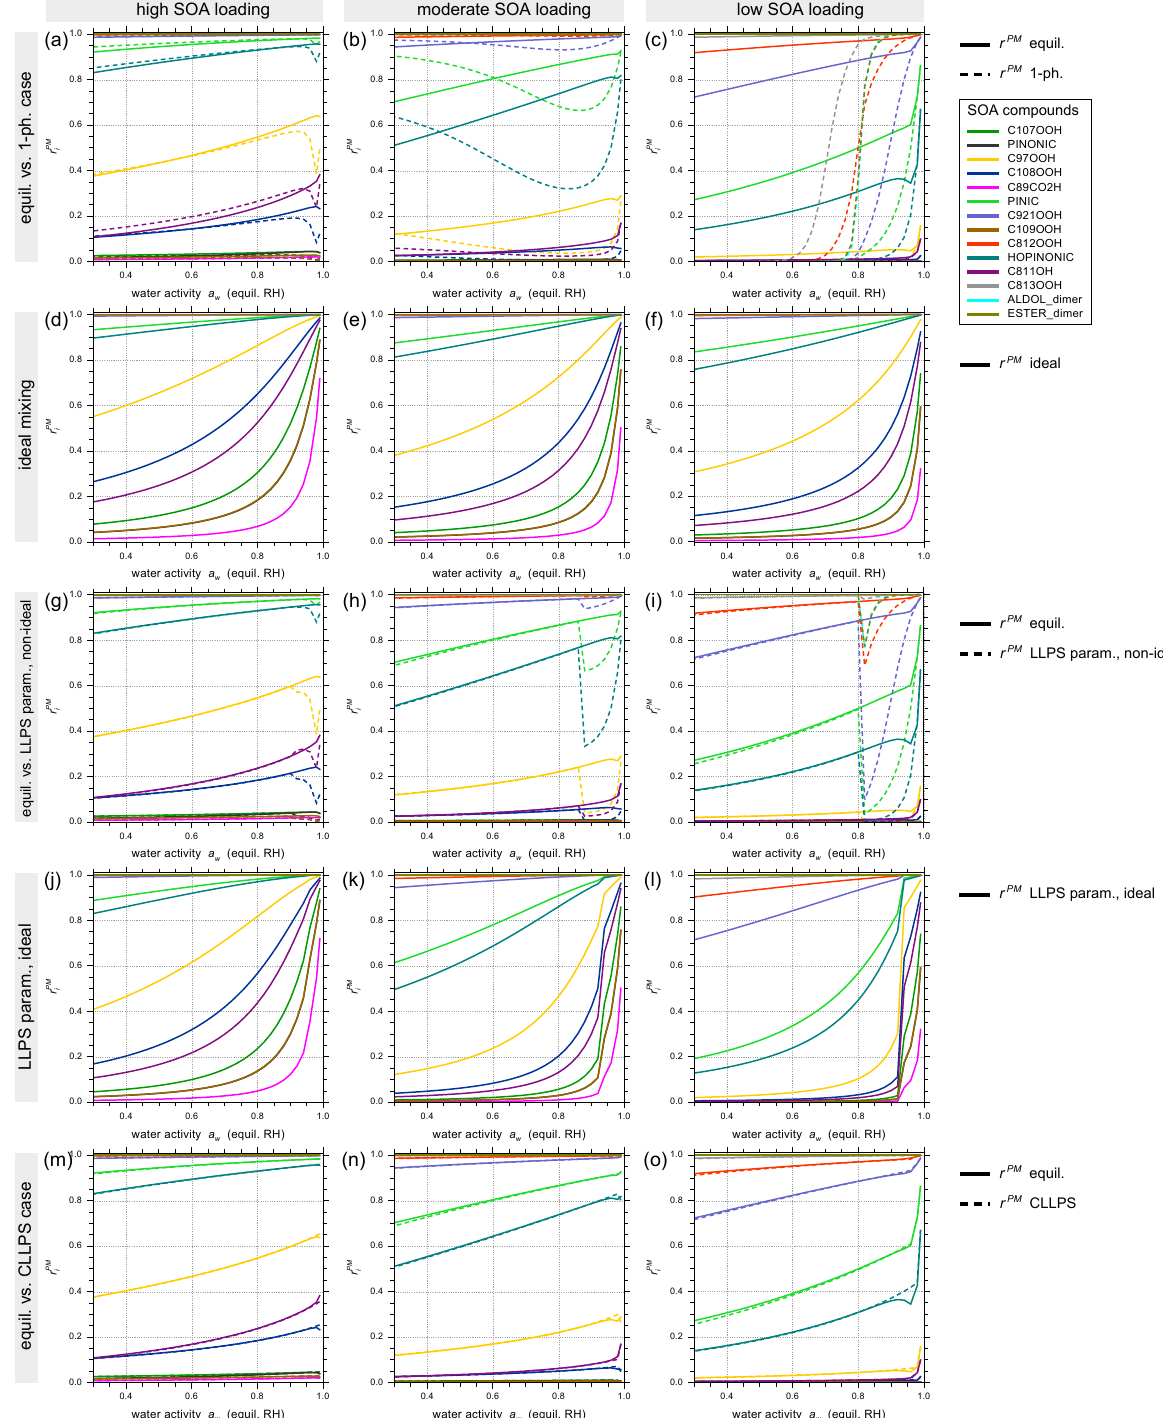
Fig. 6. PM phase fractions ( r PM ) of the organic system components as a function of RH at 298K. Comparison of the different modeling cases with the benchmark (equil.) case for predicted partitioning at three distinct SOA loading levels (see Fig. 5). The RH-dependent partitioning of SVOCs is emphasized in these diagrams. LVOCs partition mostly to the PM ( r PM > 0 . 99), IVOCs almost entirely to the gas phase ( r PM ≈ 0 . 0), showing little variation with respect to changes in RH and SOA loading. Phase separation leads to a discontinuity in the r PM curves